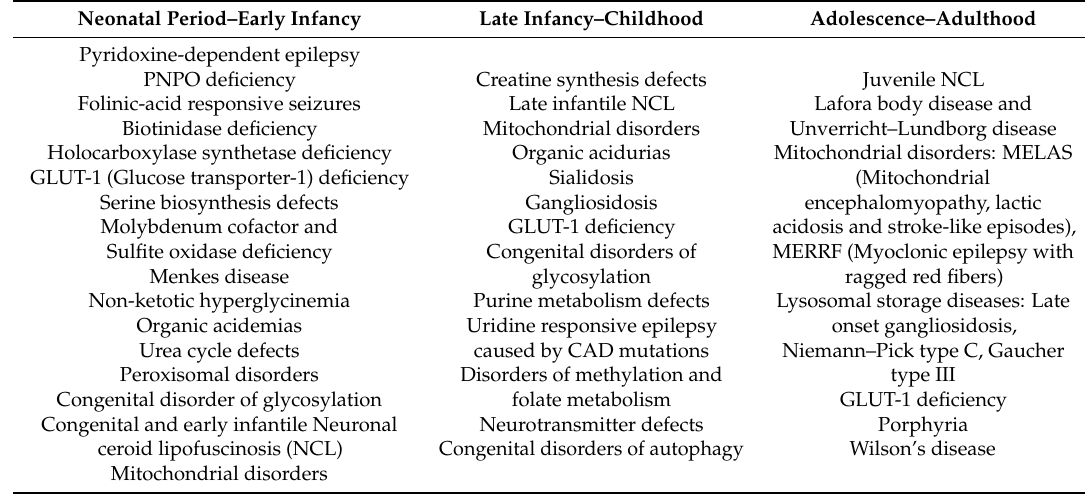
Table 1. Classification of epilepsies associated with IEM according to the age at